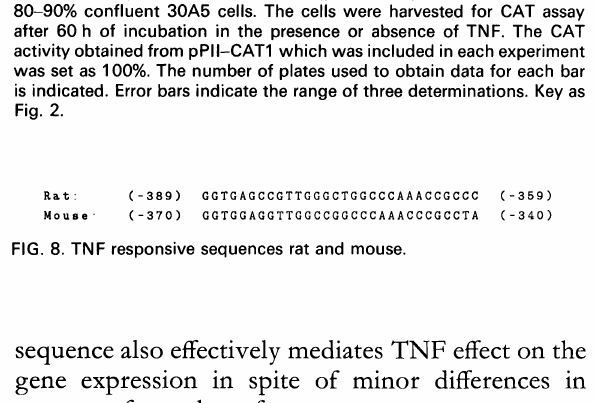
FIG. 8. TNF responsive sequences rat and mouse.